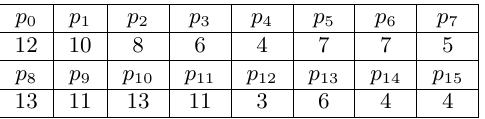
Table 2: The frequency of plaintext bytes occur in X 7 [8]